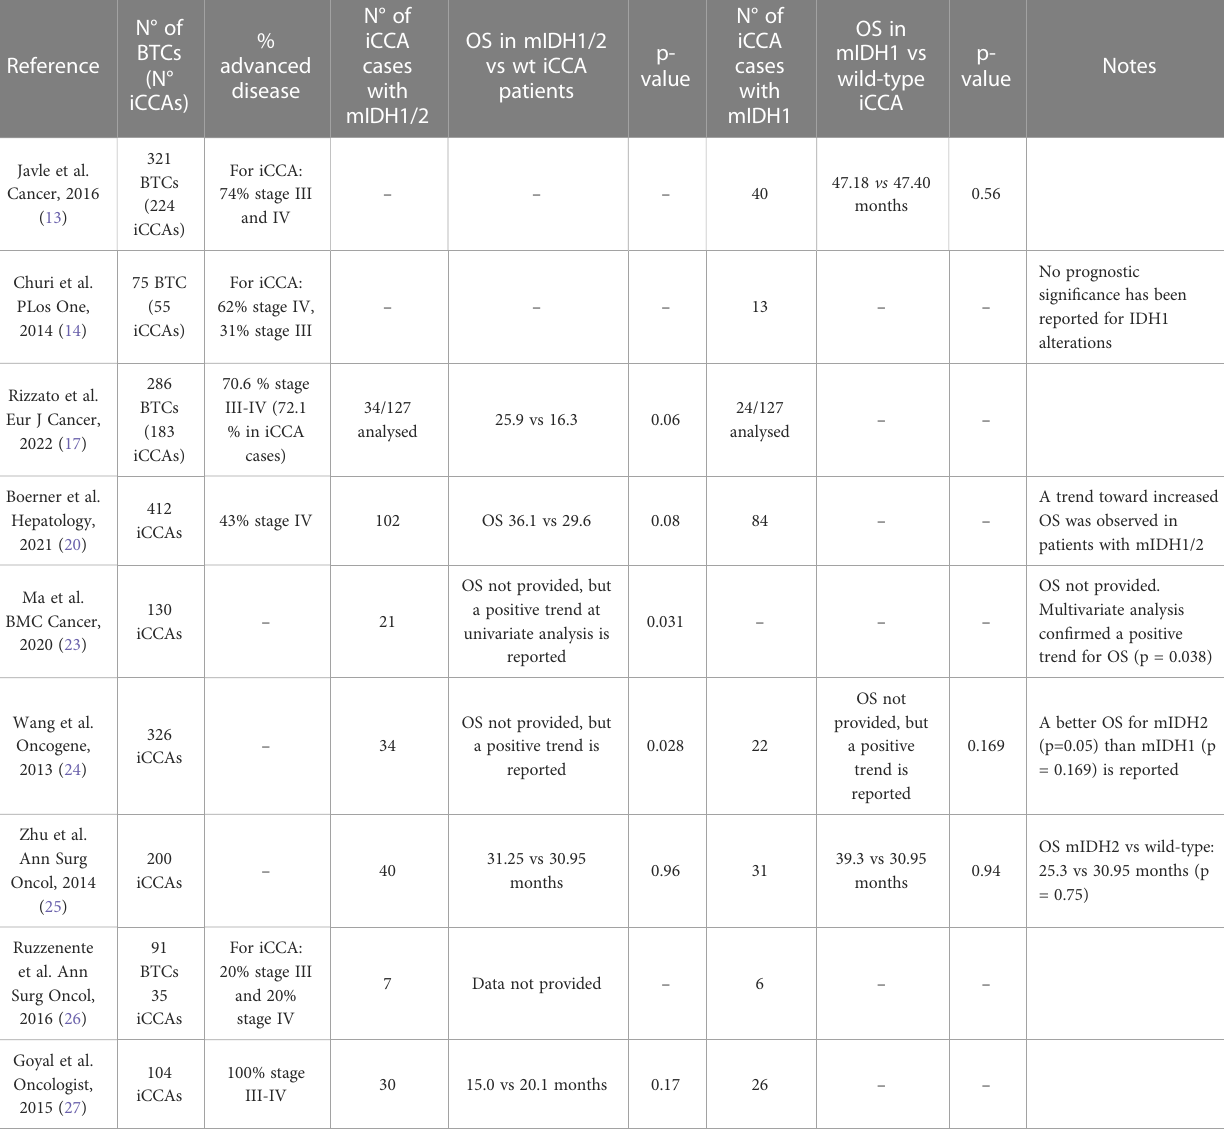
TABLE 2 OS in IDH1/2 mutated and OS in IDH1 mutated patients compared to OS in iCCA (*) or Biliary Tract Cancer BTC (#) cases.